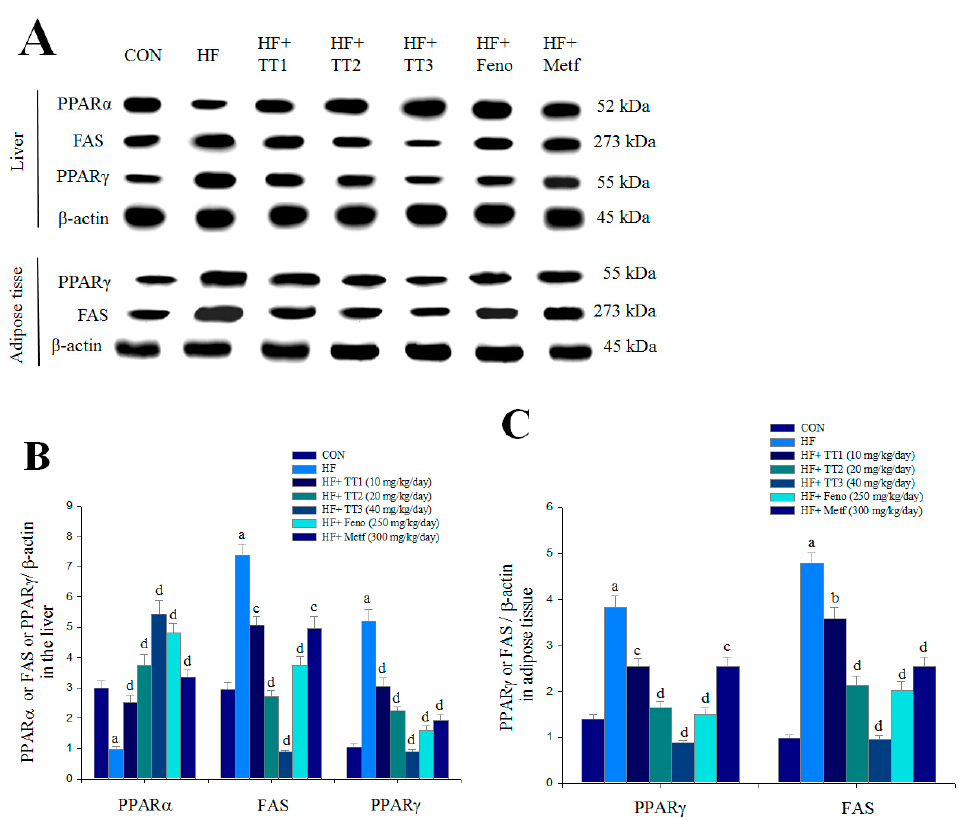
Figure 6. The hepatic expression levels of peroxisome proliferator-activated receptor α (PPAR α ), FAS, and PPAR γ , and the adipose expression levels of fatty acid synthase (FAS) and PPAR γ from the HFD-fed mice by oral gavage dehydroeburicoic acid (TT): ( A ) representative image; ( B , C ) quantification of the expression levels of PPAR α , FAS, and PPAR γ in the liver and expression levels of FAS and PPAR γ in adipose tissue. Protein was separated by 12% SDS-PAGE detected by Western blot. All values are means ± SE ( n = 9). a p < 0.001 compared with the control (CON) group; b p < 0.05, c p < 0.01, and d p < 0.001 compared with the high-fat-diet plus vehicle (distilled water) (HF) group. TT, dehydroeburicoic acid (TT1, TT2, and TT3, 10, 20, and 40 mg/kg body weight, respectively); fenofibrate (Feno, 250 mg/kg body weight), or metformin (Metf, 300 mg/kg body weight).